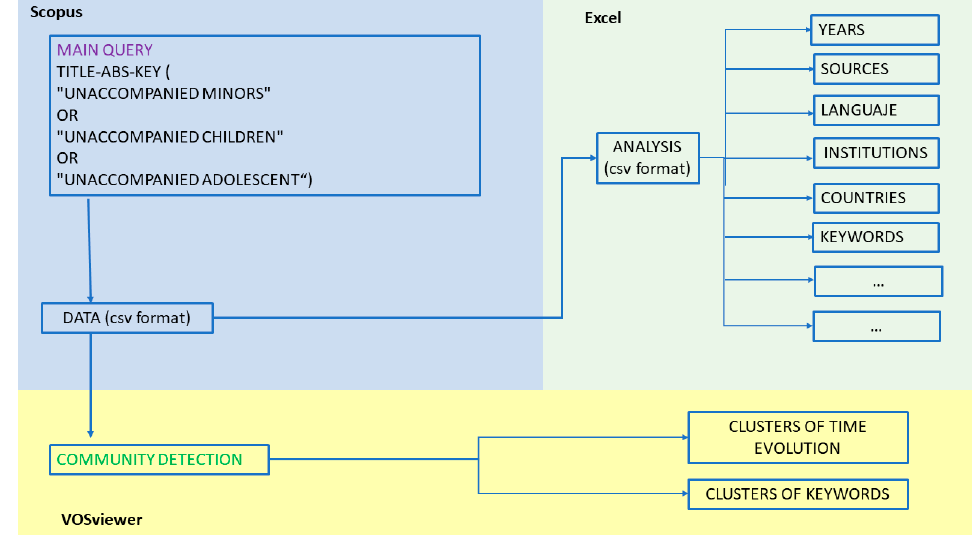
Figure 1. Flow chart of the methodology.